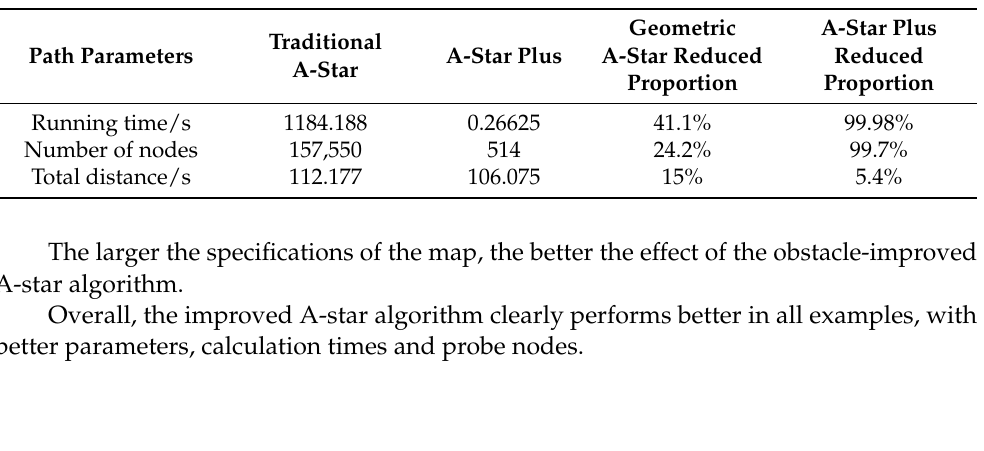
Figure 13. Comparison of calculation time between A-star algorithm and A-star Plus algorithm.